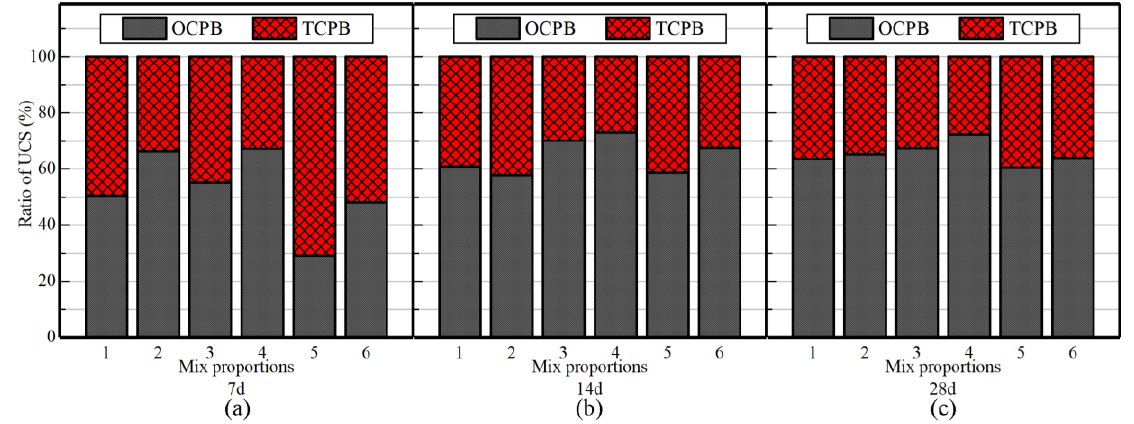
Figure 10. Growth rate ratio of OCPB and TCPB at ( a ) 7 days, ( b ) 14 days, and ( c ) 28 days.